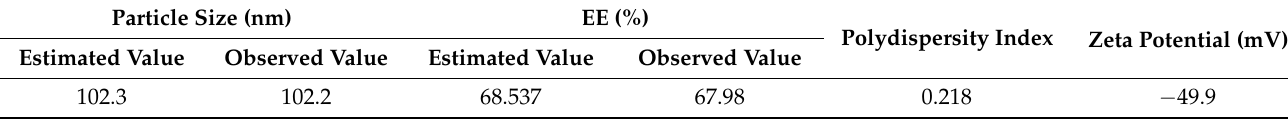
Table 2. Estimated and observed values for check point analysis of optimized batch